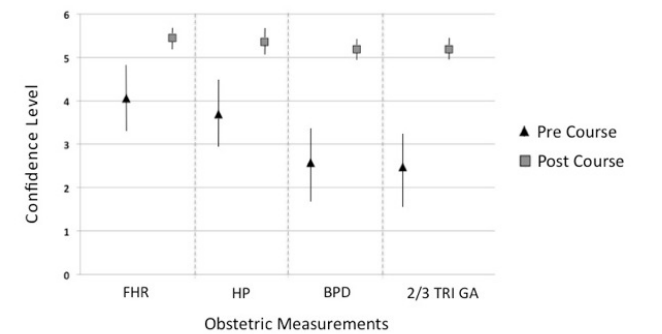
Figure. Pre and post course ultrasound confidence assessment. Improvement in confidence levels after the obstetrical ultrasound training course. FHR (fetal heart rate), HP (head position), BPD (biparietal diameter), 2/3 Tri GA (overall use of ultrasound to esti- mate gestational age in 2nd and 3rd trimester).